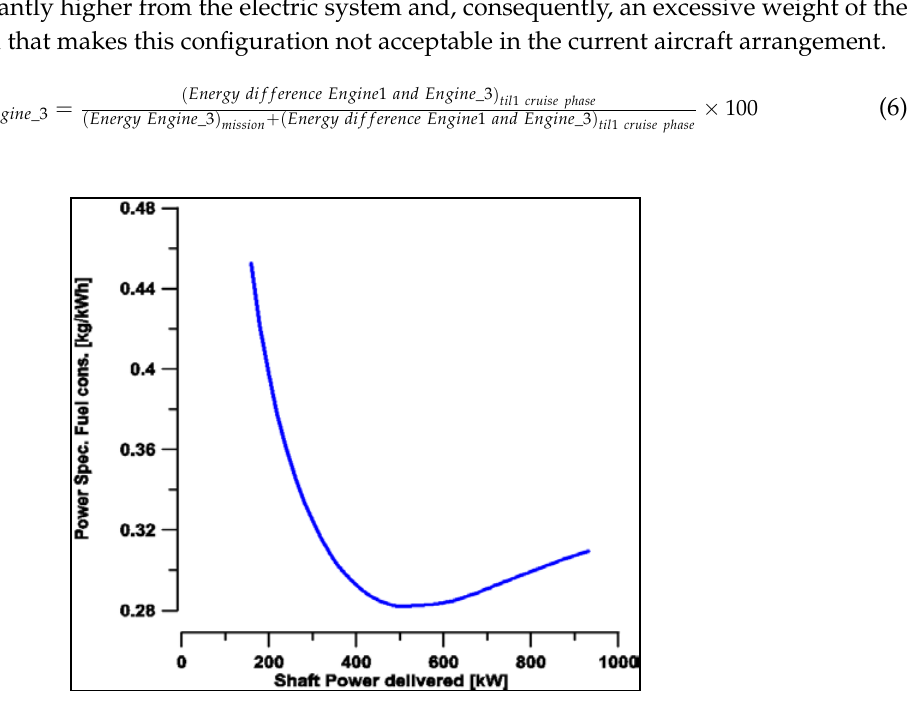
Figure 18. Specific fuel consumption vs power delivered at cruise altitude (5516 m) of Engine_3. Table 5. Emissions results with Engine_3.